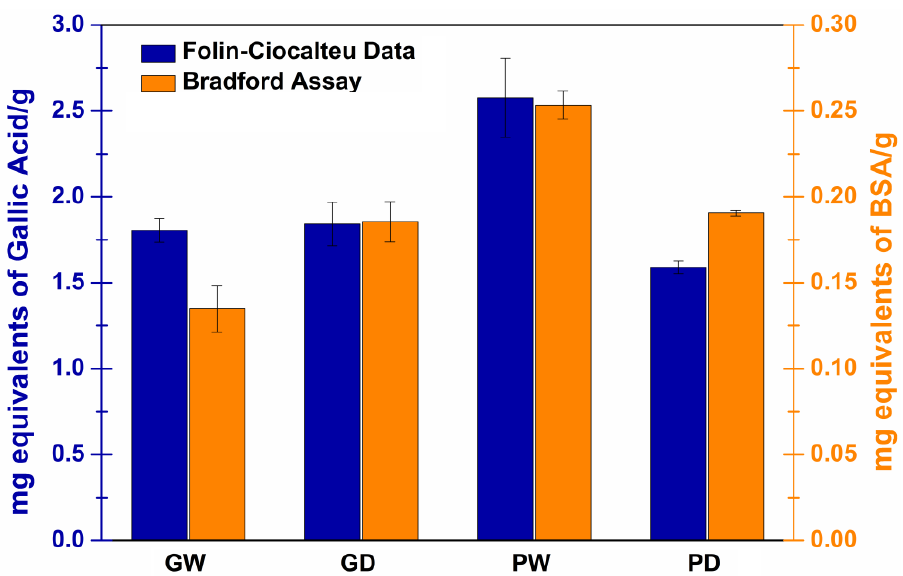
Figure 4. Folin–Ciocalteu data (blue) and Bradford assay results (orange) for all the extracts reported in terms of equivalent mg ± SE of gallic acid and bovine serum albumin used respectively as standard molecules per 1 g of extract ( n = 9).